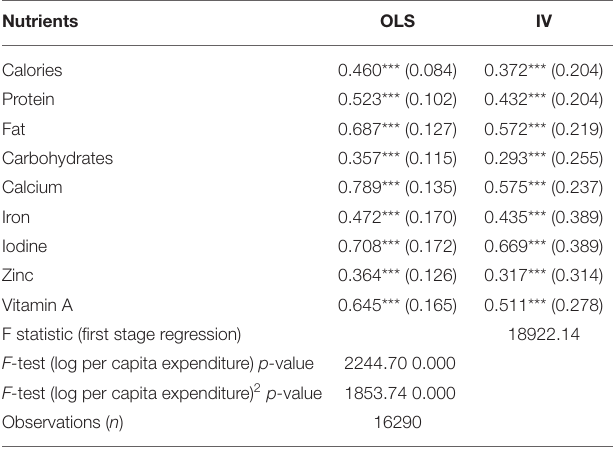
TABLE 9 | Nutrient–income elasticity estimates: non-linear specification with square term (Equation 3).